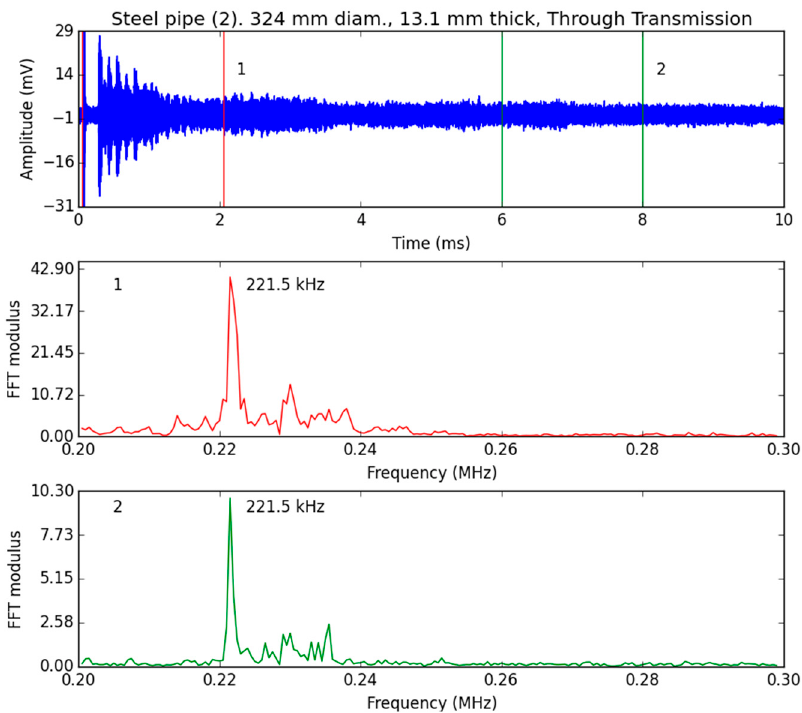
Figure 6. Through-transmission in the 2 mm-thick rubber plate. Top: signal in the time domain. Center: FFT modulus of the signal within window (1). Bottom: FFT modulus of the signal within window (2).